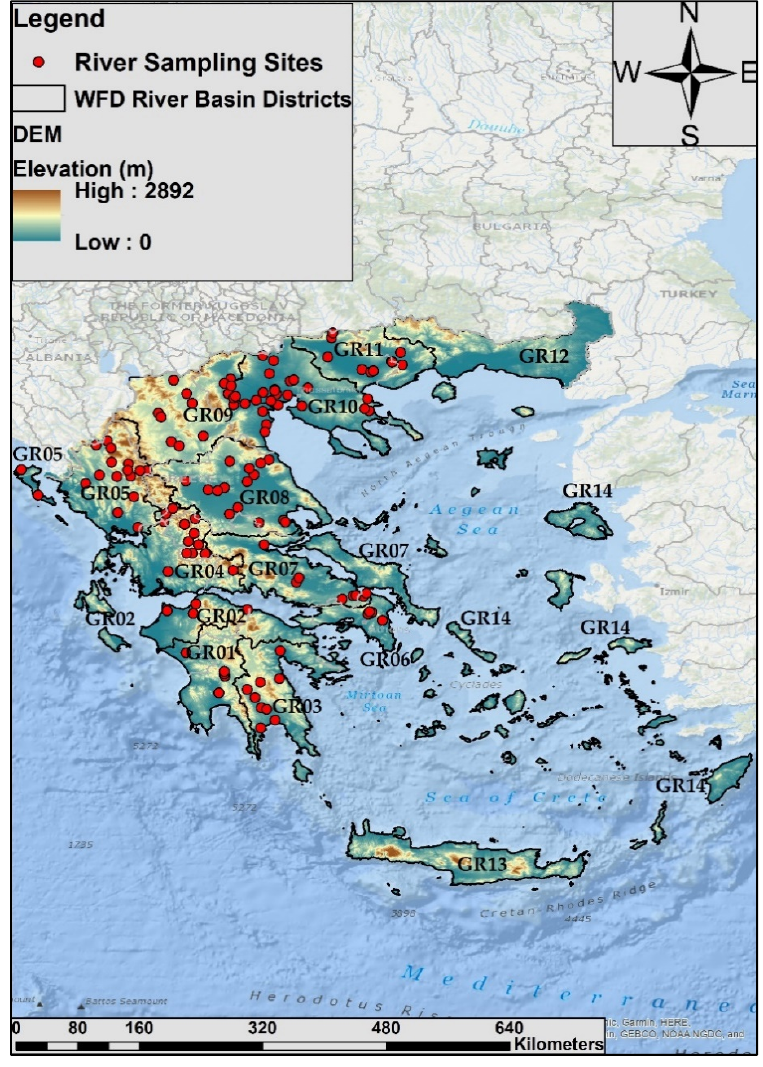
Figure 1. Distribution of the sampling sites ( n = 123) among water districts: GR01: Western Pelo- ponnese, GR02: Northern Peloponnese, GR03: Eastern Peloponnese, GR04: Western Central Greece, GR05: Epirus, GR06: Attica, GR07: Eastern Central Greece, GR08: Thessaly, GR09: Western Macedonia, GR10: Central Macedonia, GR11: Eastern Macedonia, GR12: Thrace, GR13: Crete, GR14: North Aegean Islands.